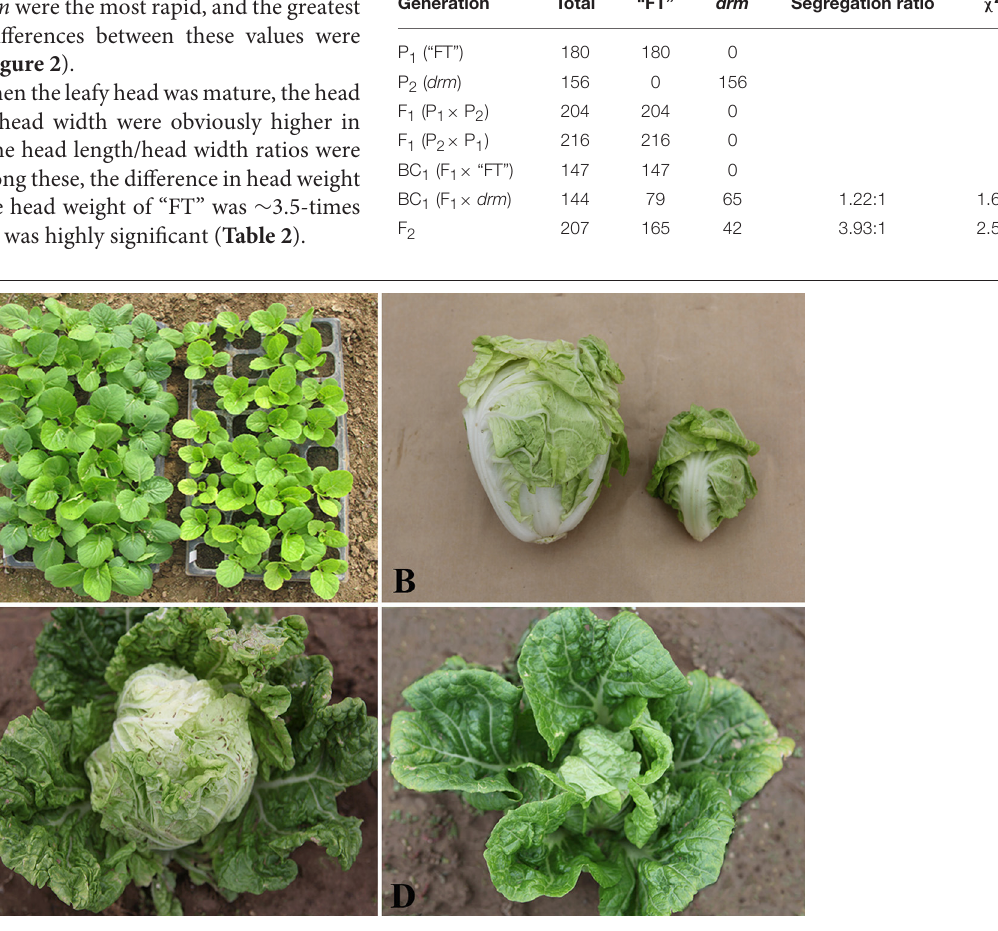
Frontiers in Plant Science |